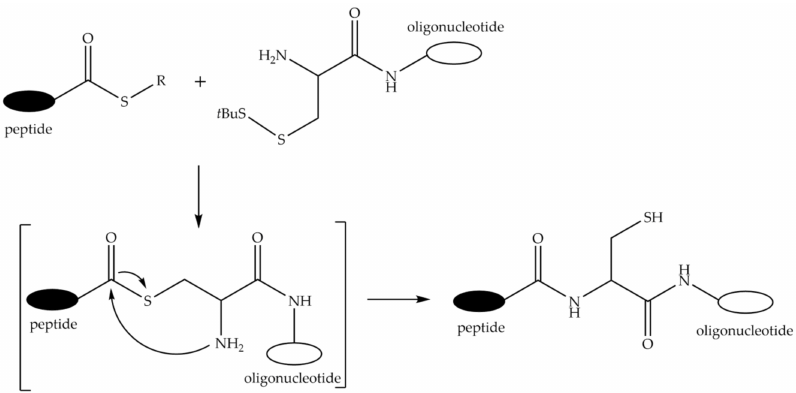
Figure 16. Synthesis of peptide-oligonucleotide conjugates via native chemical ligation. R—benzyl